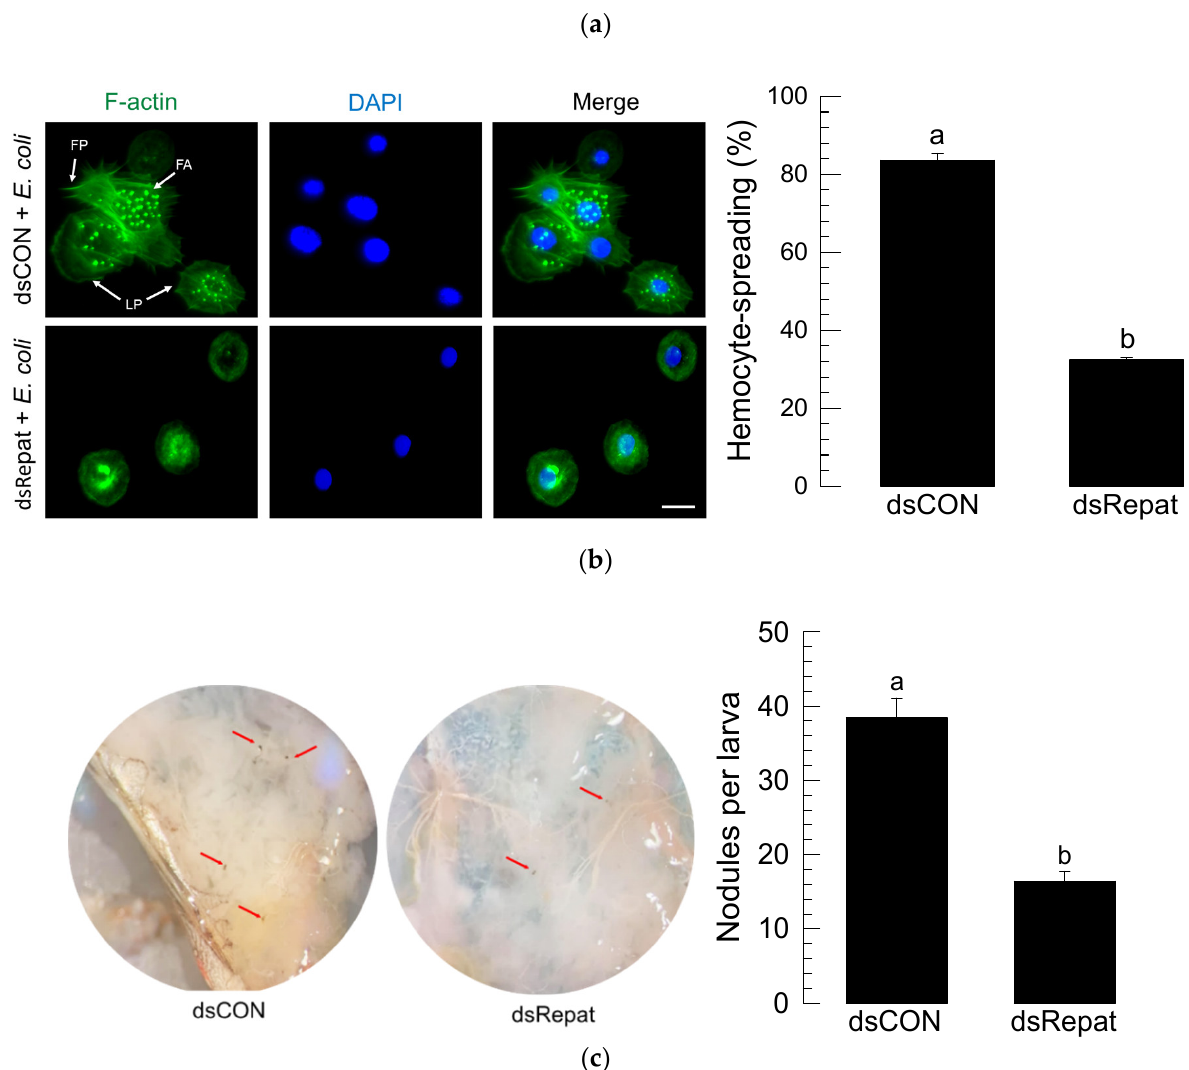
Figure 3. Effect of RNA interference (RNAi) of Repat33 expression on cellular immune responses of L5 larvae of S. exigua . ( a ) Change of Repat33 expression level in fat body after injection of dsRNA (‘dsRepat’, 1 µg/larva) specific to Repat33 . A GFP gene was used to construct control dsRNA (‘dsCON’). Each treatment was replicated three times with independent tissue preparations. ( b ) Influence of RNAi on hemocyte-spreading behavior in response to bacterial challenge. E. coli (10 4 cells/larva) was injected to L5 larvae at 24 h after injection of dsRepat. At 8 h after injection, hemolymph was collected and